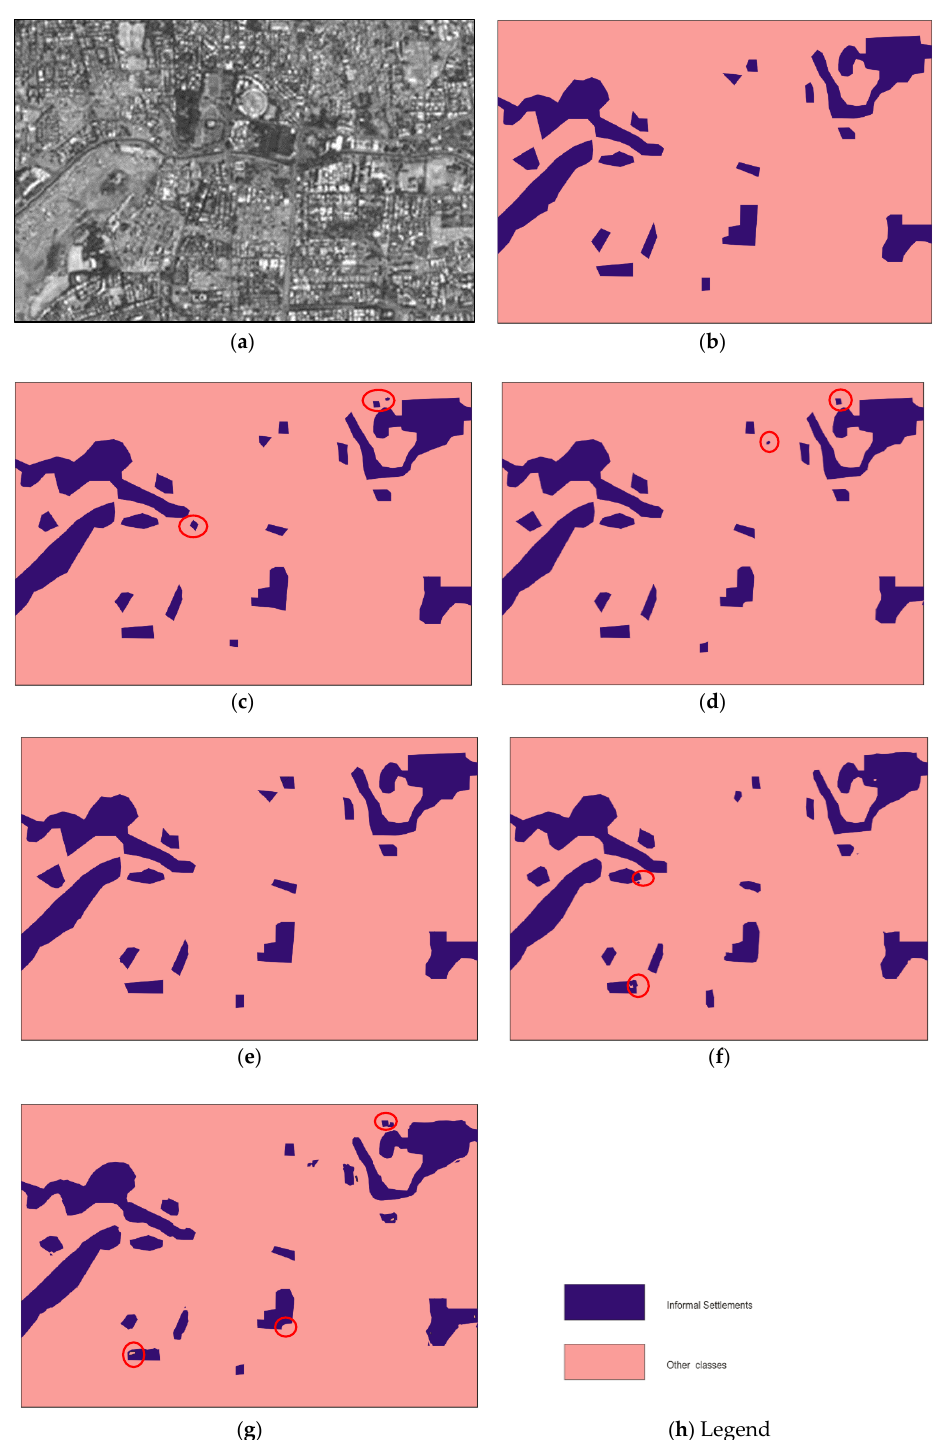
Figure 3. Informal settlement identification for parts of Pune city: ( a ) original image; ( b ) reference; ( c ) using plain U-net, with misclassifications circled in red; ( d ) using wavelet-assisted U-net, with misclassifications circled in red; ( e ) using contourlet-assisted U-net; ( f ) using contourlet texture features [20]; ( g ) using wavelet texture features [20]; ( h ) Table 1. Performance comparison.